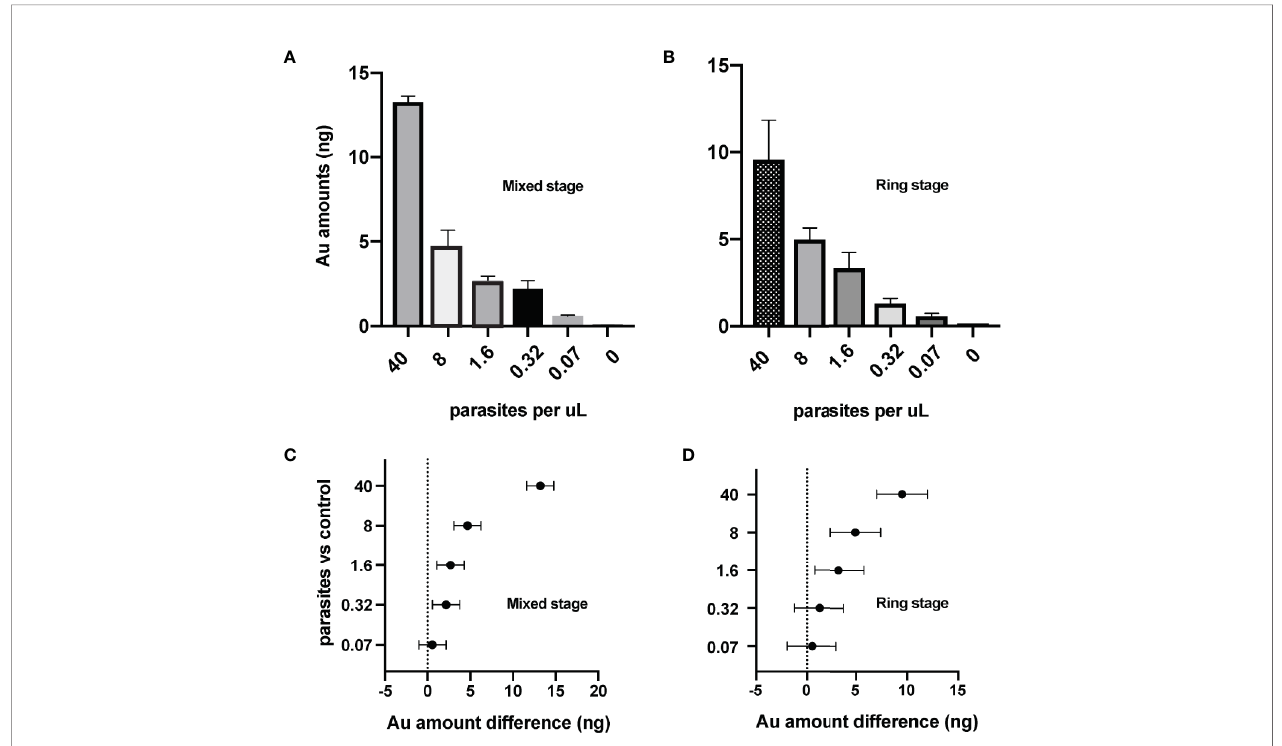
FIGURE 3 | Sensitive detection of the P. falciparum parasites by ICP-MS immunoassay targeting the PfLDH antigen. The ICP-MS method is able to detect AuNPs from different samples of (A) mixed stage and (B) ring stage P. falciparum -infected erythrocytes. Limits of detection (LOD) of the ICP-MS PfLDH immunoassay are estimated to be (C) 0.3 p/µl for the mixed stages, and (D) 1.6 p/µl for the ring stages. The horizontal bars represent the 95% con fi dence interval. The averages are from experiments repeated separately on different